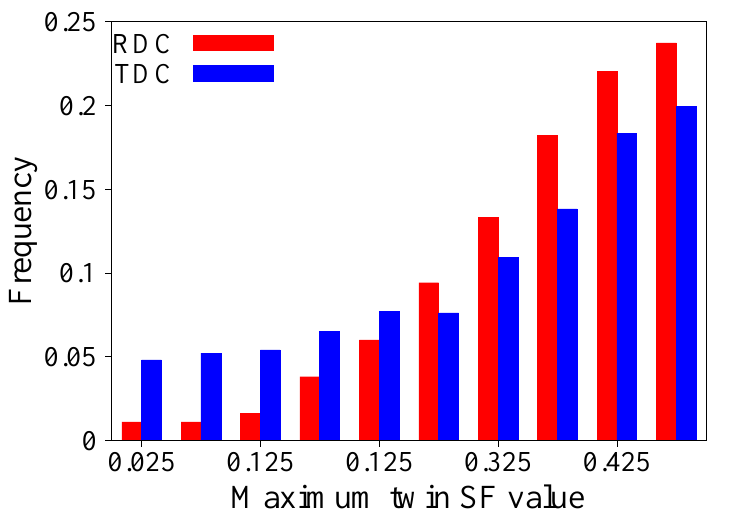
Figure 9. The distribution of the maximum twin Schmid factor for compression along the rolling (RDC) and transverse (TDC) direction of the initial rolling texture is plotted in Figure 4.